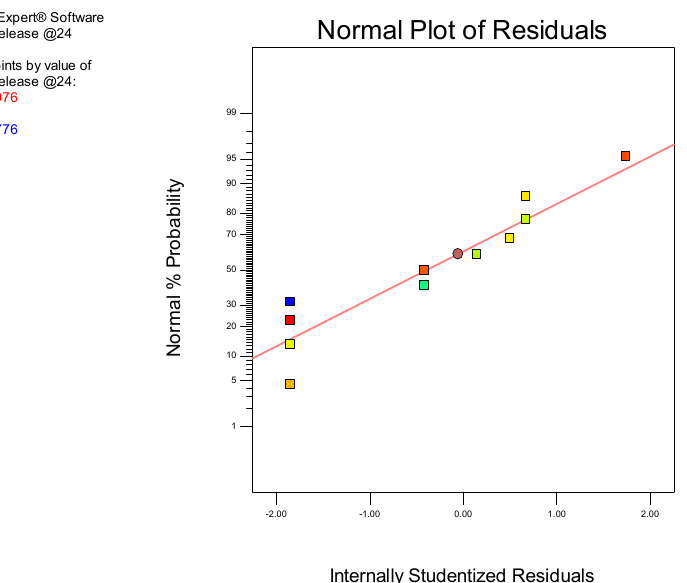
Figure 5. Normal plot of residuals for % INH released in pH 6.8 0.1 M phosphate bu ff er at 24 h. The ANOVA results for % INH released in pH 6.8, 0.1 M phosphate bu ff er at 24 h are summarised in Table